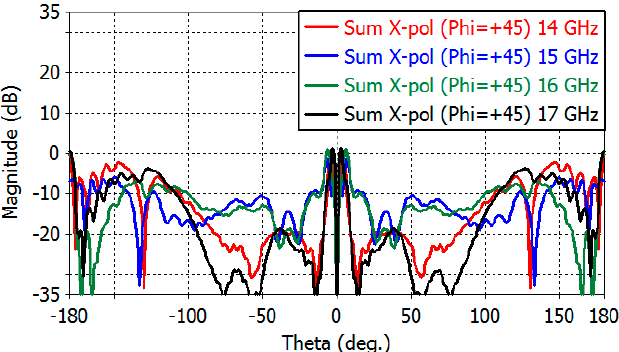
Figure 14. Diagonal-plane cross-polarization directivity of the sum channel (–180° to 180°).